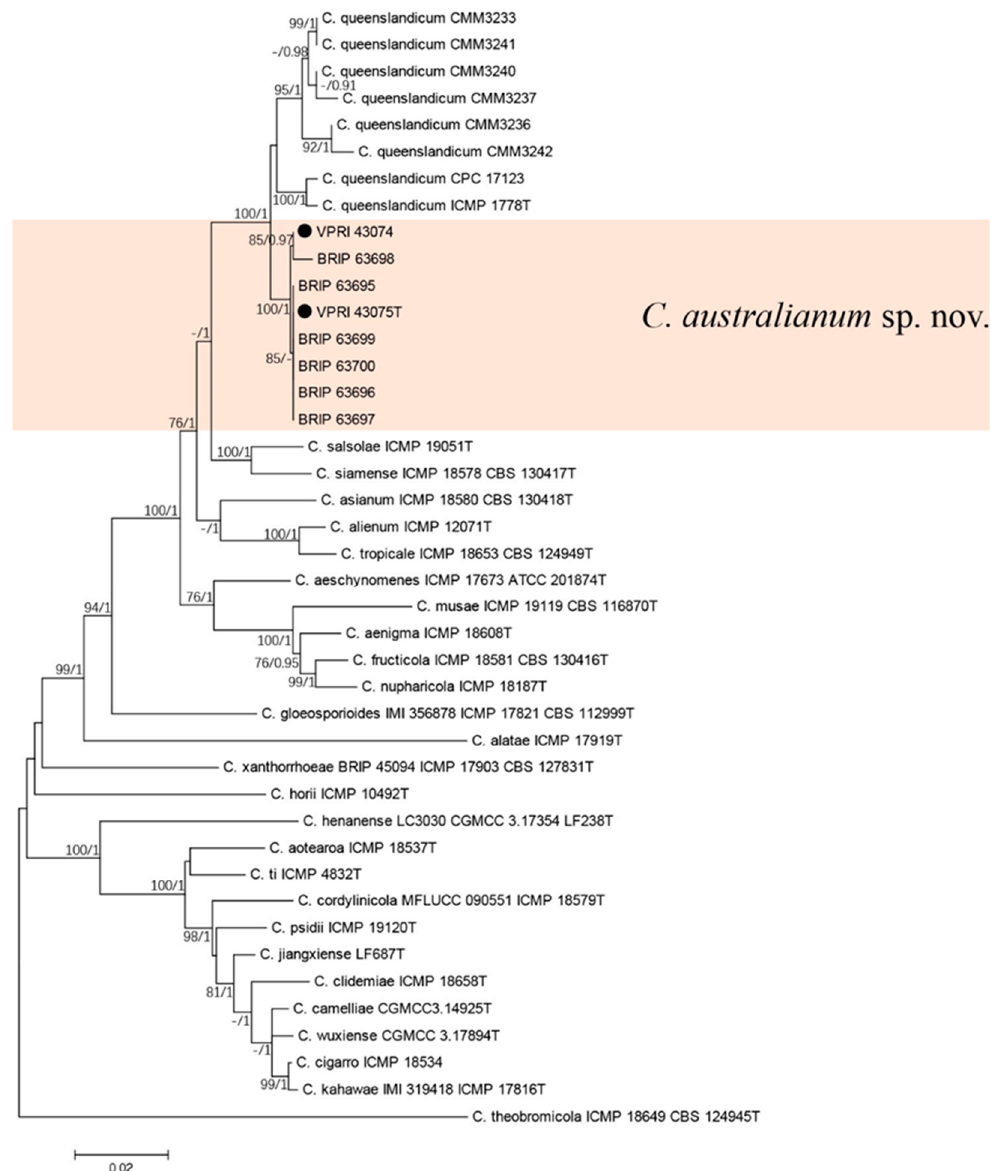
Figure 4. Phylogenetic analysis of the combined ApMat and GS sequence alignment of Colletotrichum australianum sp. nov. The bootstrap support values (ML > 75%) of maximum likelihood analysis and Bayesian posterior probabilities (PP > 0.90) are displayed at the nodes (ML/PP). Black circle denotes isolates from Citrus spp.